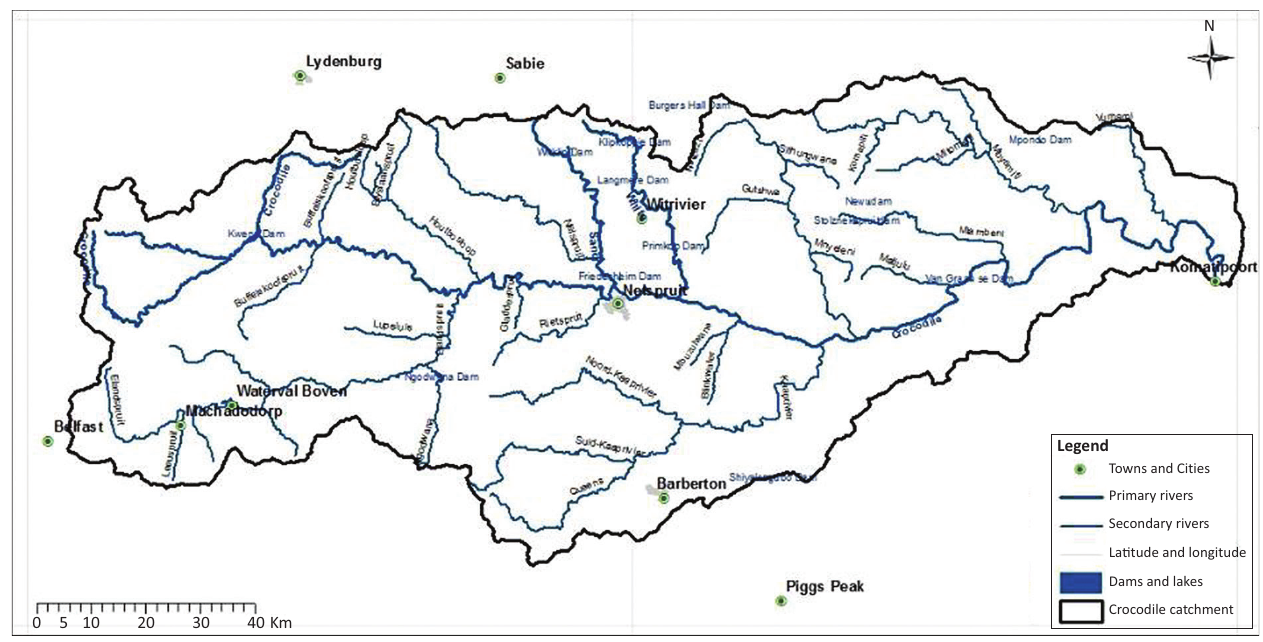
FIGURE 1: Drainage system of Incomati catchment showing the position of Nelspruit and its environs.